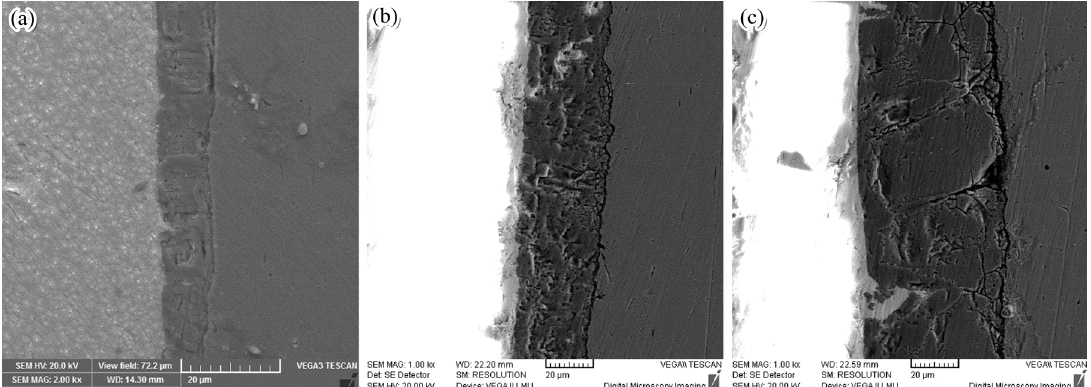
Figure 4. SEM of cross section oxide scale of rolled samples. (a) 850°C-6s-20%; (b) 950°C-60s-30%; (c) 1000°C-6s-40%.